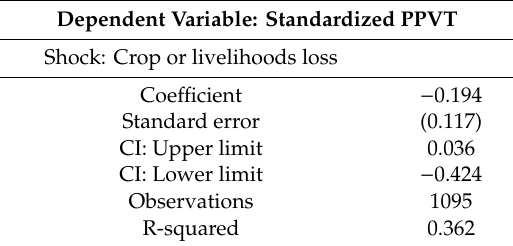
Table A2. Test for exogeneity assumption of the IV.